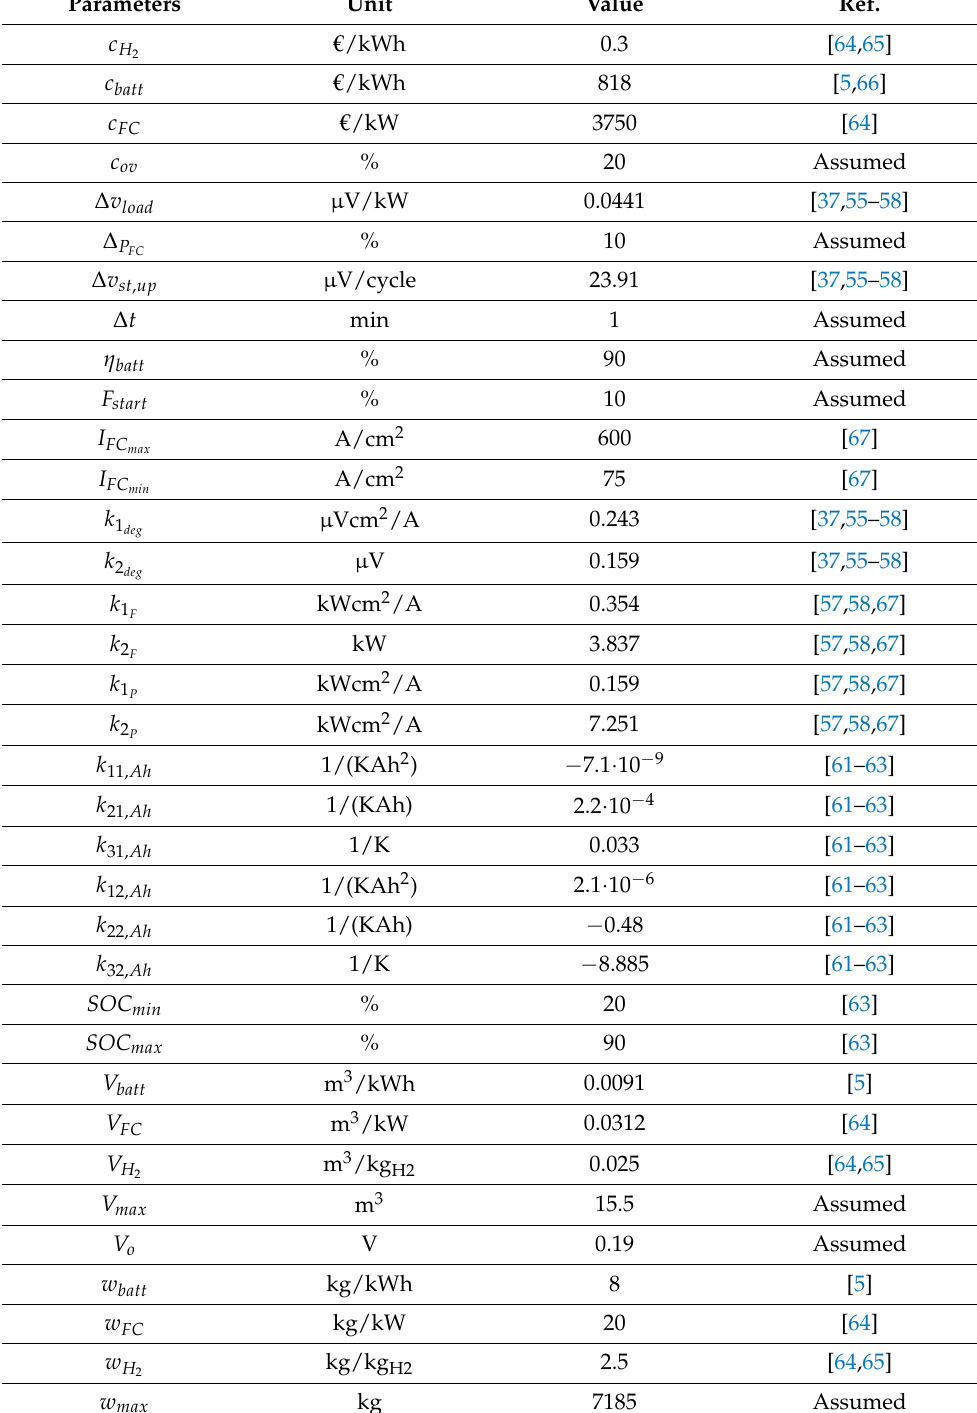
Table 3. Input parameters of the multi-objective